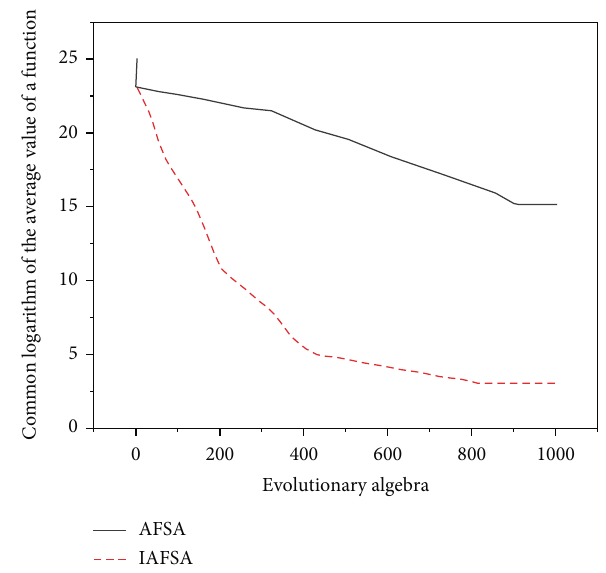
Figure 12: Evolution curve of average optimal value of function f 1 .